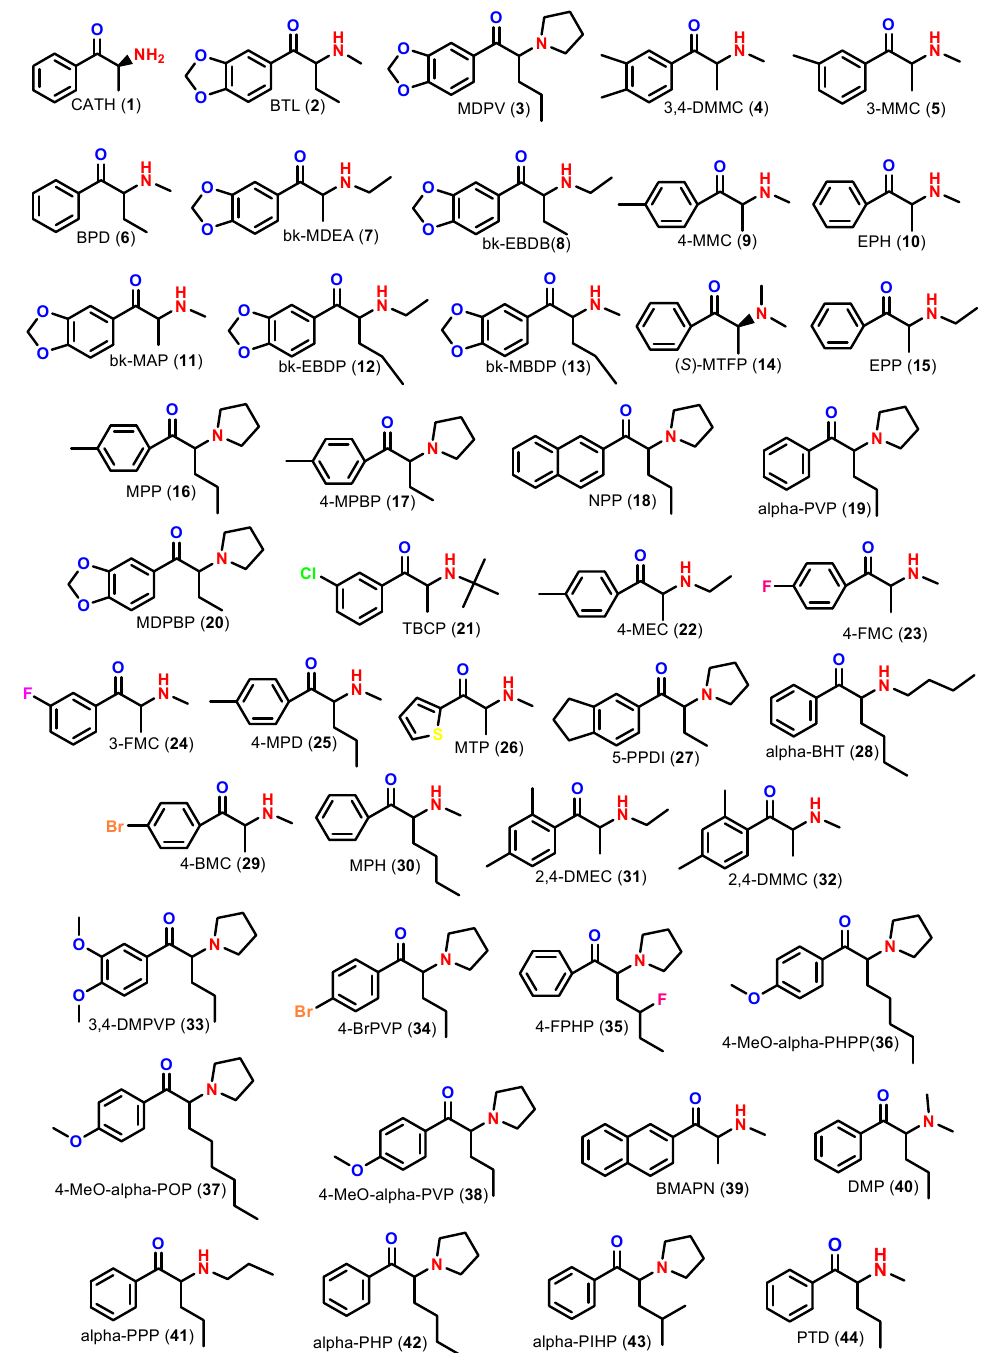
Figure 1. Chemical structures of 44 emergent SC selected for in silico studies, namely: CATH: cathinone or norephedrone ( 1 ); BTL: butylone ( 2 ); MDPV: 3,4-methylenedioxypyrovalerone ( 3 ); 3,4-DMMC: 3,4-dimethylmethcathinone ( 4 ); 3-MMC: 3-methylmethcathinone ( 5 ); BPD: buphedrone ( 6 ); bk-MDEA: ethylone ( 7 ); bk-EBDB: eutylone ( 8 ); 4-MMC: mephedrone or 4-methylmethcathinone